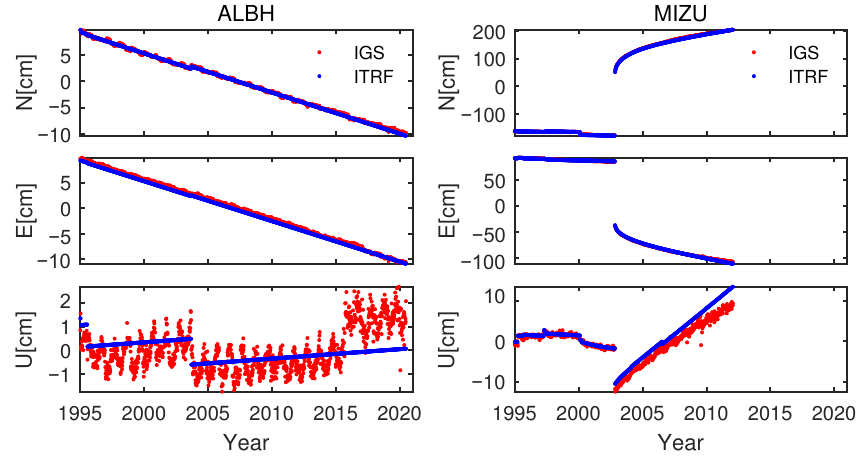
Figure 3. ITRF2014 and IGS station coordinate time series in the NEU coordinate system of ALBH ( left ) and MIZU ( right ). The average values of IGS solutions are taken from individual